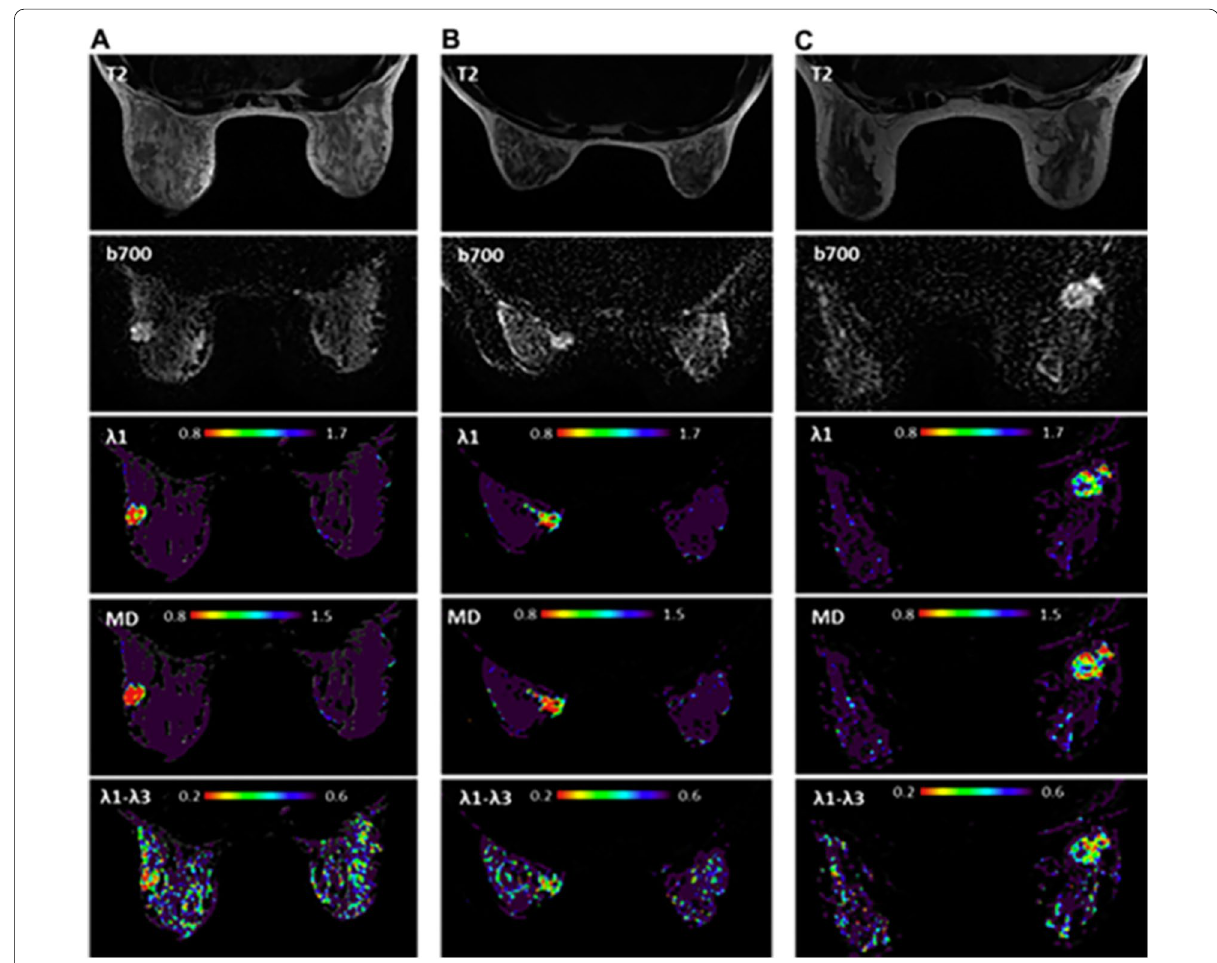
Fig. 11 Unenhanced diffusion MRI during pregnancy. T2, DWI, and DTI parametric maps of three PABC patients ( A – C ). T2‑weighted, DWI and DTI‑derived diagnostic parametric maps of λ 1, MD, and λ 1– λ 3 of three patients with newly diagnosed IDC are presented. The lesion appears bright on DWI (b 700 s/mm 2 ). Using the parametric threshold, the lesion could be easily depicted on l1, and MD maps, as well as on l1–l3 map, compared with the measurements in the normal tissue. Reproduced with permission from Journal of the American College of